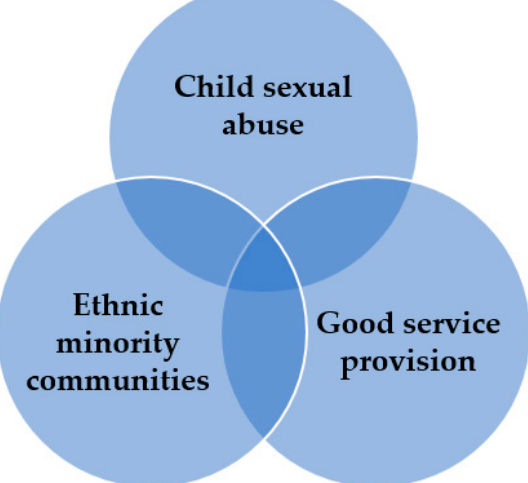
Figure 1. Three overlapping ‘circles’ of knowledge required for good service provision for ethnic minority client victims/survivors of CSA.